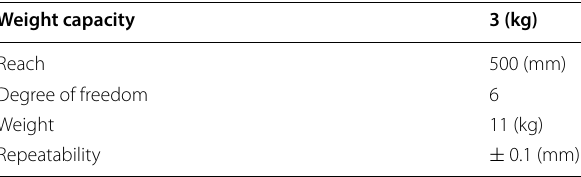
Table 2 UR3 specifications